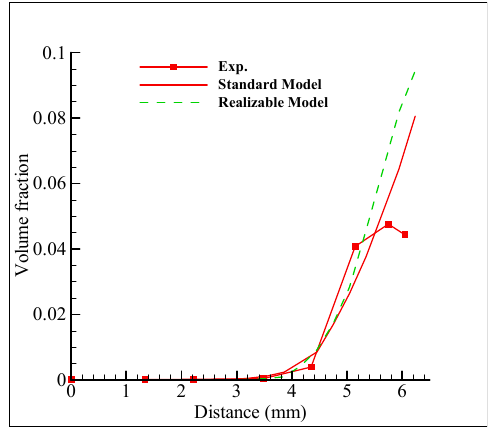
Figure 1. Turbulence model test.